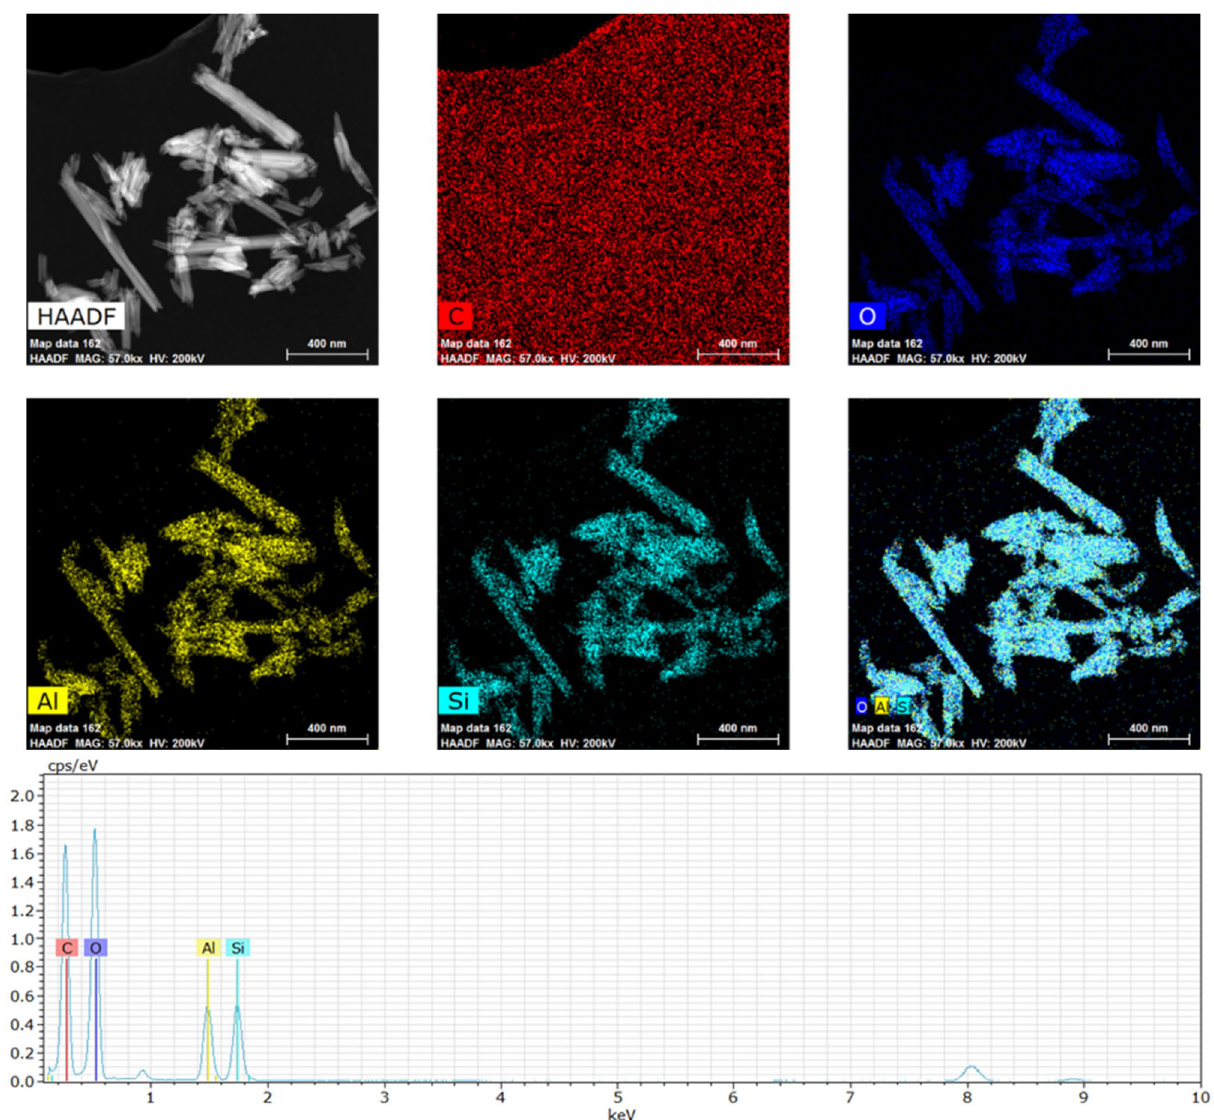
Figure 5. EDS mapping and EDS spectrum of HNTs before